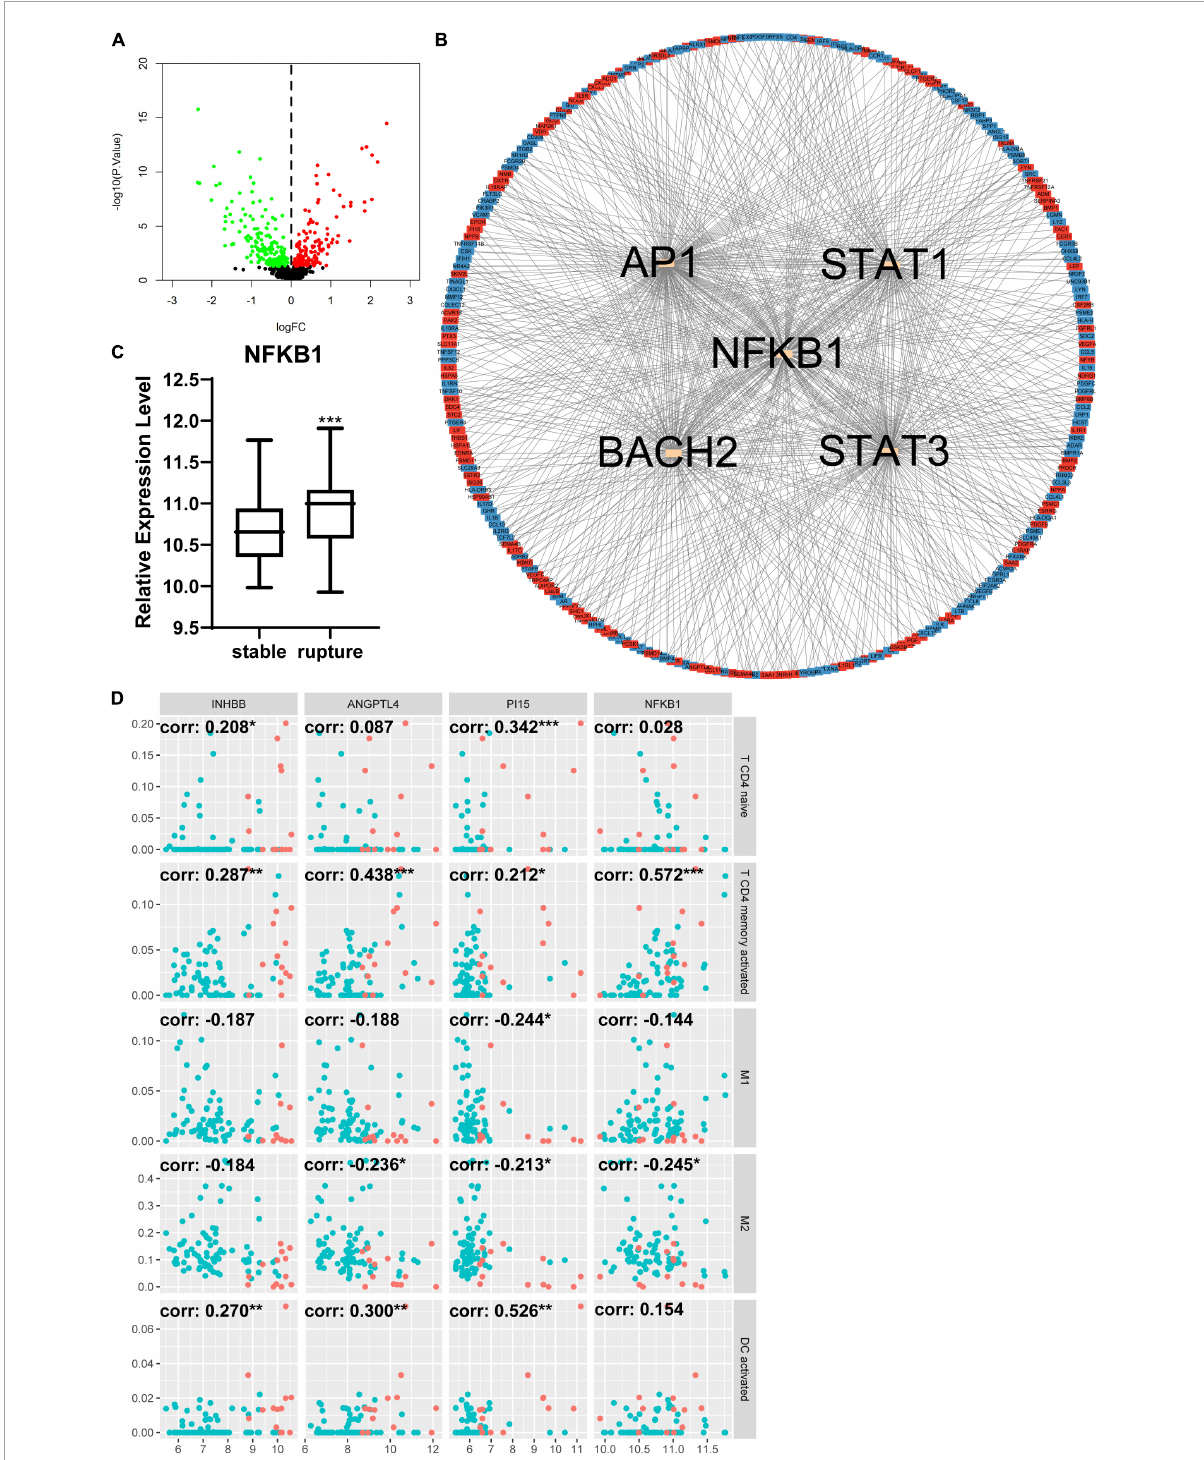
FIGURE7 Differentially expressed immune and inflammation-related genes (DEIRGs) between stable AAA group and aortic rupture group. (A) The volcano plot of DEIRGs between stable AAA group and aortic rupture group. Dots in green: downregulated gene, dots in red: upregulated gene. (B) The PPI network of DEIRGs and upstream transcription factors. (C) The expression level of NFKB1 in stable AAA group and aortic rupture group. (D) The relationship between top three upregulated DEIRGs, NFKB1, and significantly changed immune cells. Dots in blue: stable AAA samples, dots in red: aortic rupture samples. AAA, abdominal aortic aneurysm; PPI, protein–protein interaction; NFKB1, nuclear factor kappa B 1; corr, correlation coefficient. * p < 0.05, ** p < 0.01, *** p <